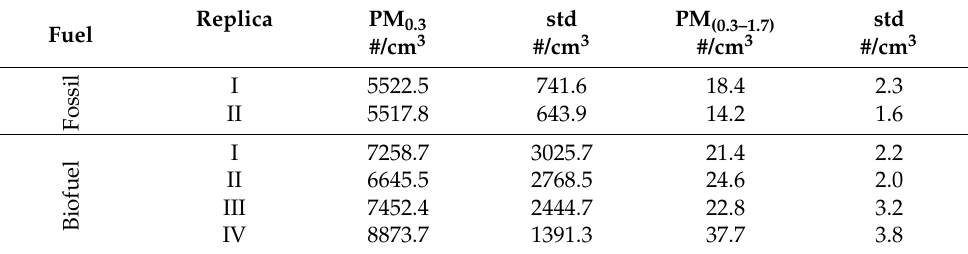
Table A4. Particulate matter emission indexes (number of particles-#-per cubic cm) measured during background monitoring.